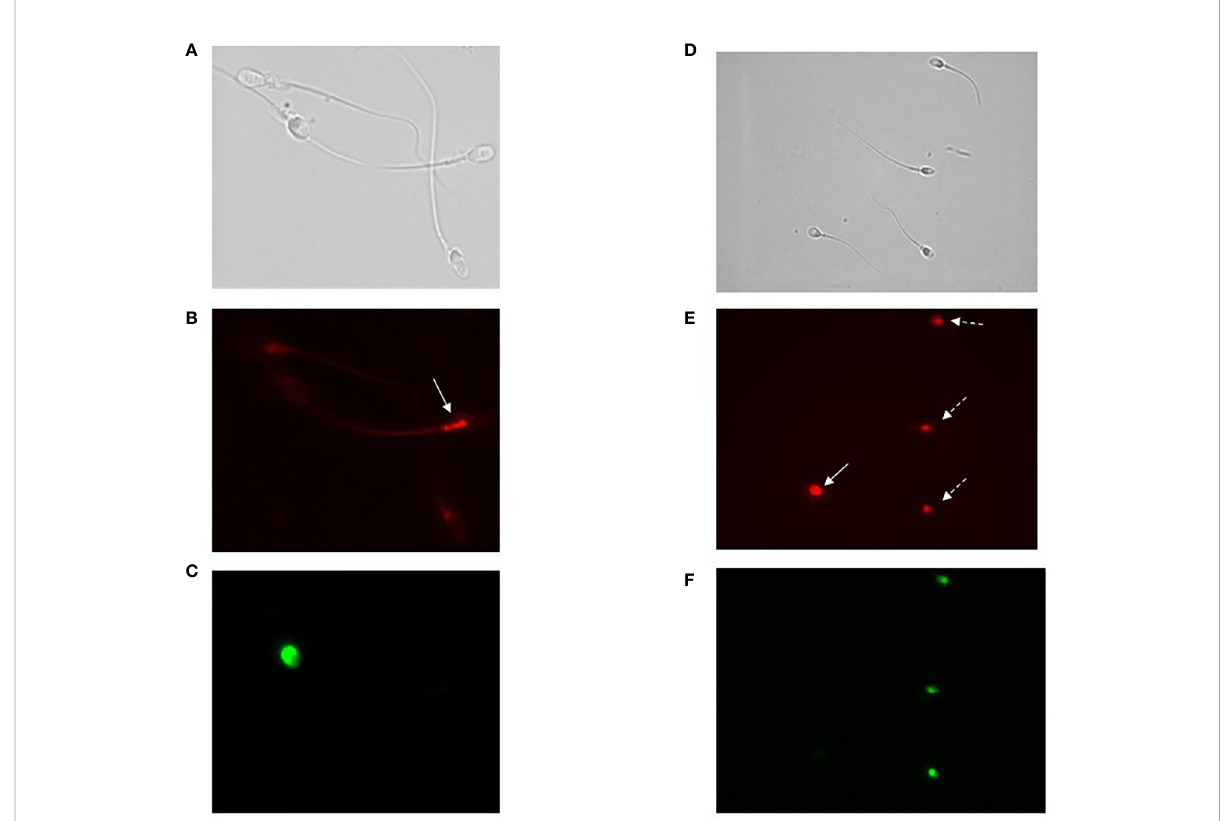
FIGURE 3 (A – C) Images of fl uorescence microscopy of bright fi eld (A) , CellROX ® Orange (B) and Y1 (C) stained spermatozoa. As observed, spermatozoa positive to CellROX ® Orange are negative to Y1 and vice versa. The arrow indicates the CellROX ® Orange fl uorescent signal at midpiece level (B) . (D – F) Images of fl uorescence microscopy of bright fi eld (D) , DHE (E) and Y1 (F) stained spermatozoa. As observed, spermatozoa positive to DHE resulted to be both negative (white whole arrow) and positive (white dotted arrows) to Y1. The fl uorescent signal related to the DHE is localized in the sperm head (E)